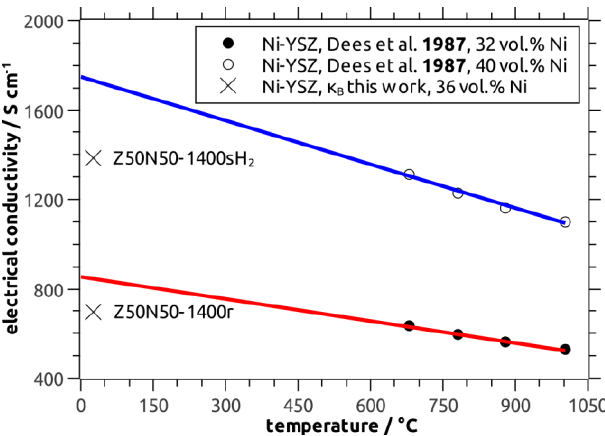
Figure 10. Bulk electric conductivity of Z50N50 Ni–YSZ cermets (36 vol.% Ni) calculated using Equation (3) (X) compared to literature data measured for Ni–YSZ with 32 vol.% Ni (closed symbols, red line) and 40 vol.% Ni (open circles, blue line). Note: the literature data were extrapolated to room temperature applying a linear regression.